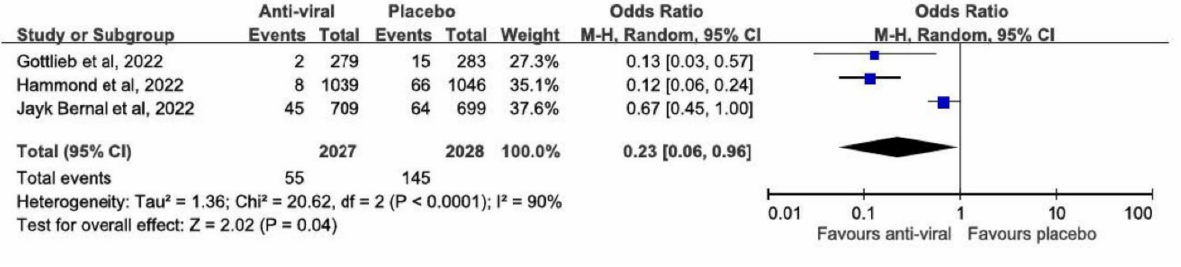
Figure 3. Meta-analysis of the associations of anti-viral agents versus placebo with the risk of COVID-19-related hospitalization or death